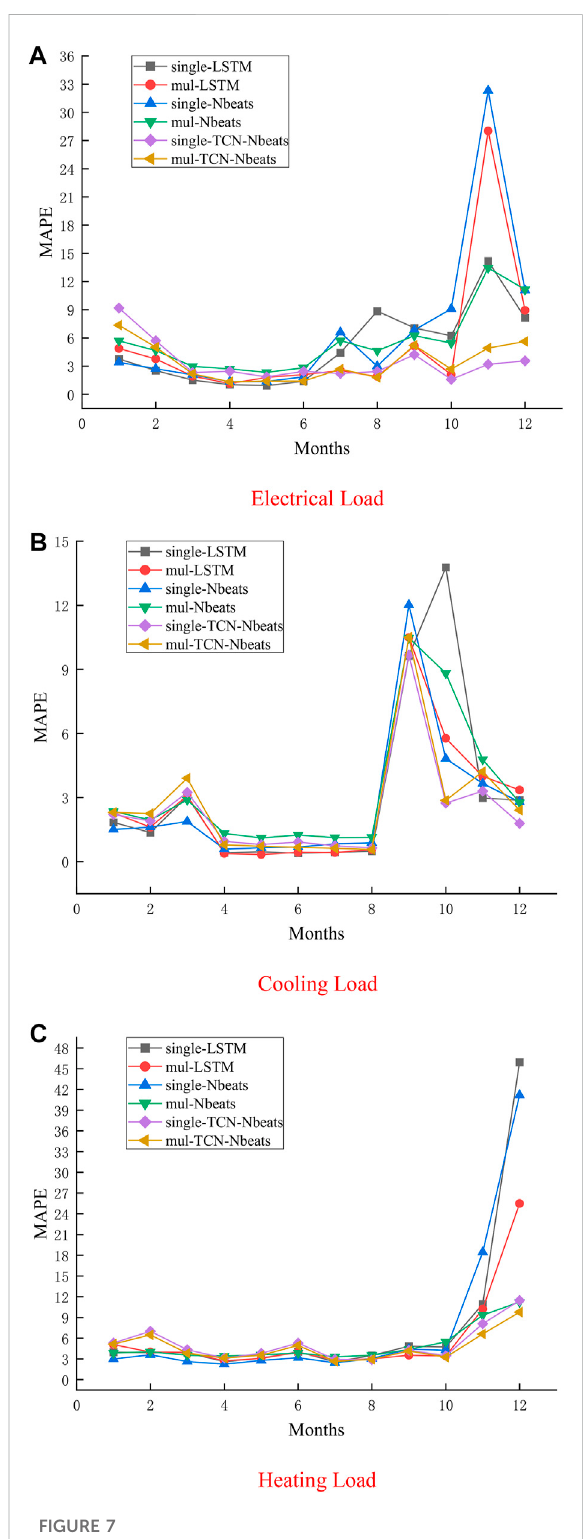
FIGURE 7 MAPE corresponding to each month under different forecasting